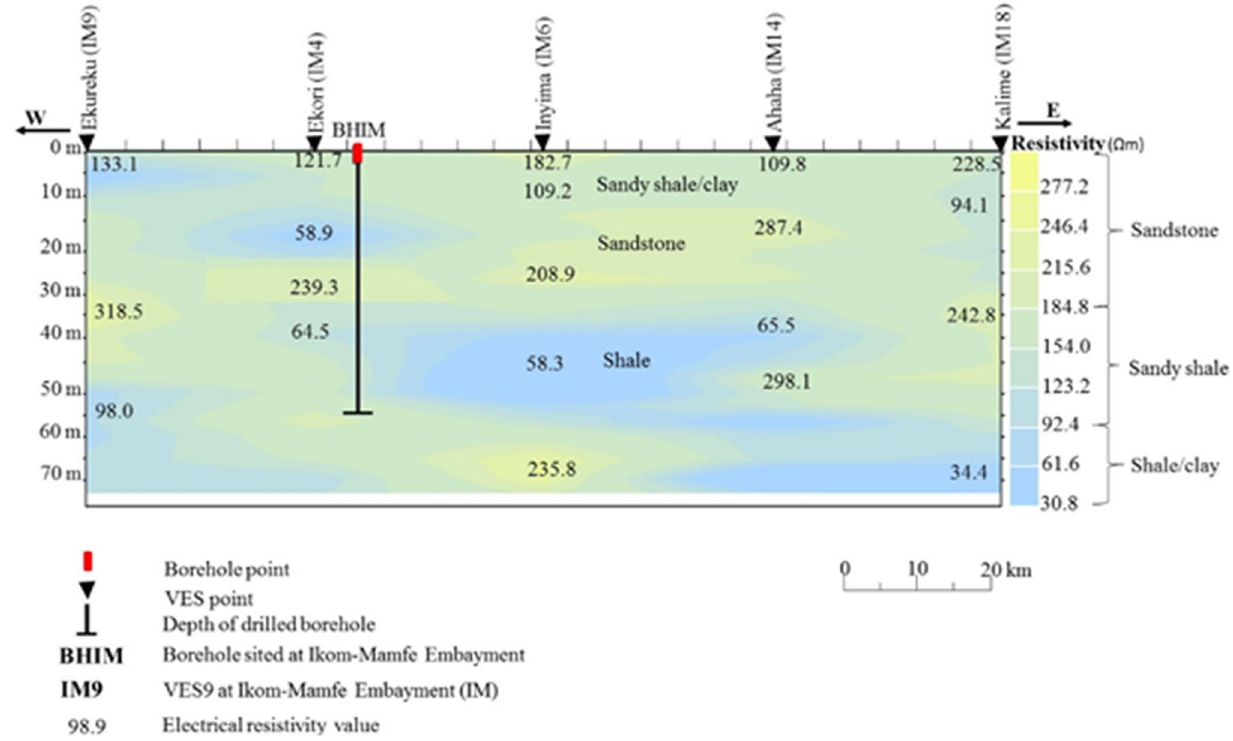
Fig. 9 Electro-stratigraphic section oriented E–W in the